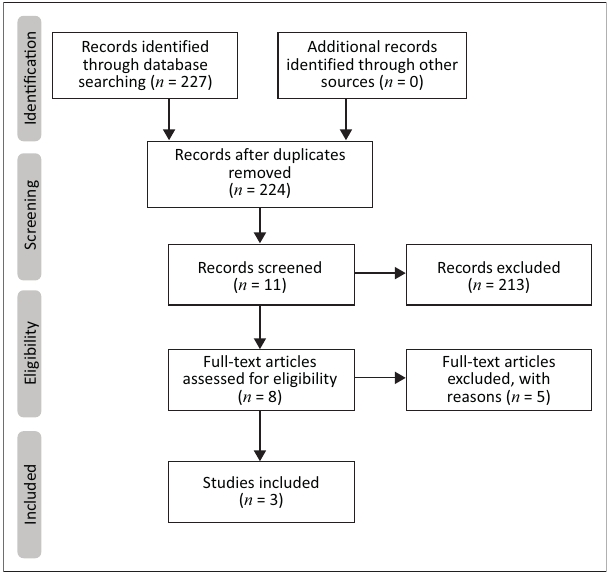
FIGURE 1: Preferred reporting items for systematic reviews and meta-analysis flow diagram for scoping reviews TABLE 2: Emergent themes in relation to the objectives of this study. Objective Theme